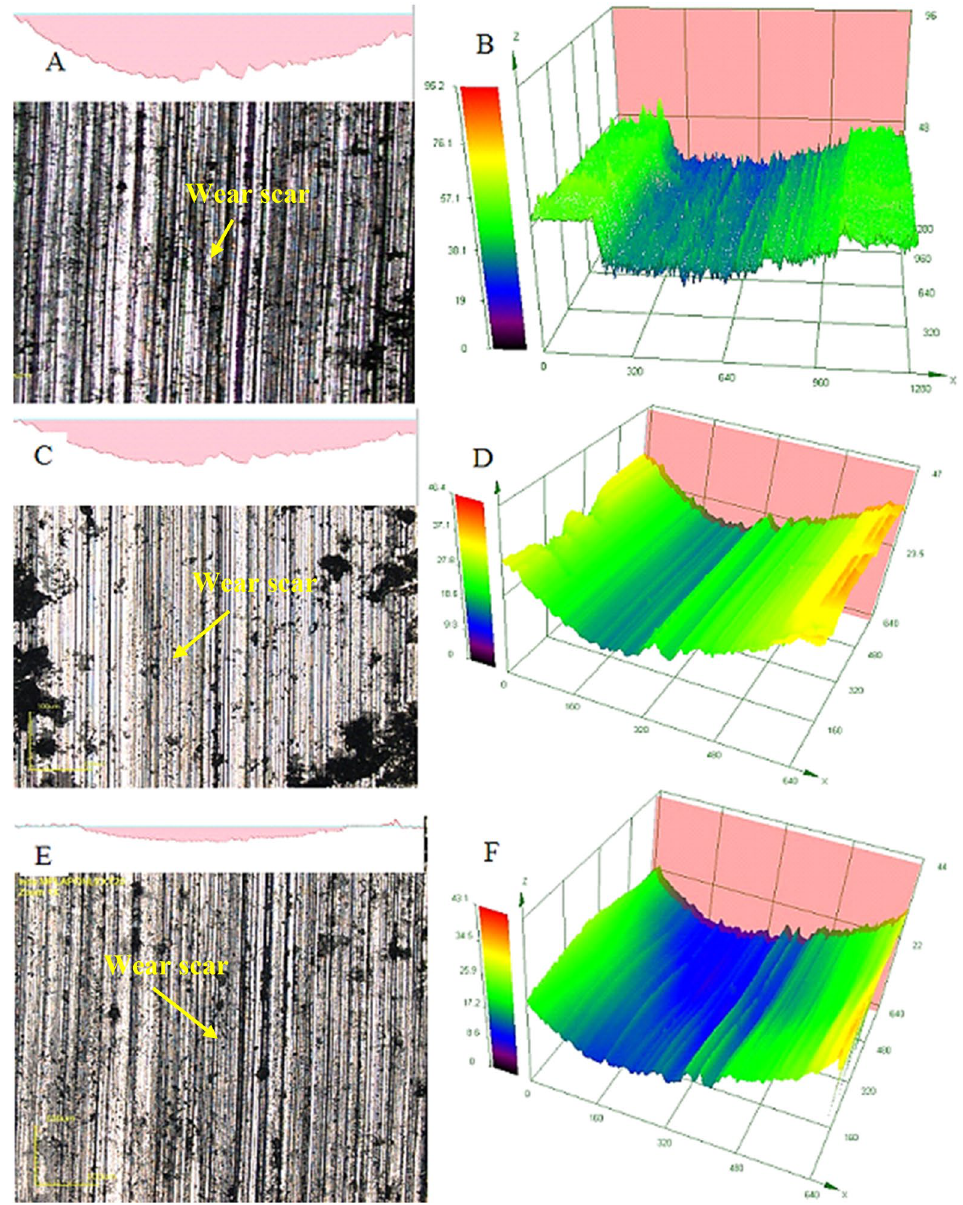
Figure 11. Wear track for untreated Ti-6Al-4 V sample ( A ) depth of the wear scar for untreated titanium alloy ( B ) Confocal topographical map of the wear scar for untreated titanium alloy ( C ) depth of the wear scar for the sample treated with S1-40 nm Al 2 O 3 -250 nm TiO 2 ( D ) Confocal topographical map of the wear scar for the sample treated with S1-40 nm Al 2 O 3 -250 nm TiO 2 ( E ) depth of the wear scar for the sample treated with